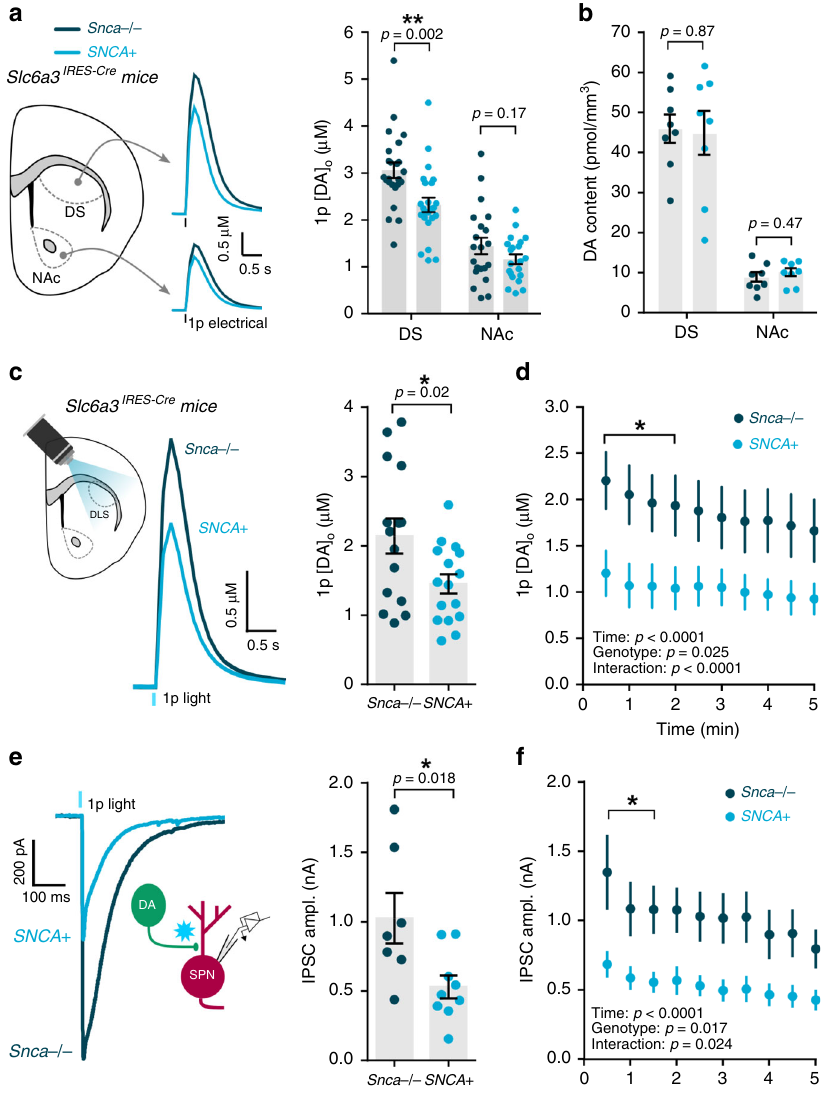
Fig. 7 Attenuated striatal GABA and DA co-release from DA axons in mouse model of early parkinsonism. a Left, mean [DA] o pro fi les vs. time evoked by a single pulse ( 1p ) of electrical stimulation in dorsal striatum (DS) and nucleus accumbens (NAc) of SNCA + mice (light blue) and littermate controls ( Snca − / − , dark blue) at 3 – 4 months, backcrossed onto an Slc6a3 IRES-Cre background. Right, Mean 1p-evoked [DA] o (in μ M) from Left ( n = 24 observations/5 mice per genotype in DS, n = 21 observations/5 mice per genotype in NAc). b Mean DA content in DS and NAc of SNCA + mice (light blue) and littermate controls ( Snca − / − , dark blue) ( n = 8 experiments/5 mice per genotype in DS and NAc). c Left, mean [DA] o pro fi les vs. time following 1p light simulation in DLS of SNCA + mice (light blue) and littermate controls ( Snca − / − , dark blue). Right, Mean 1p-evoked [DA] o (in μ M) from Left ( n = 15 observations/3 mice in Snca − / − mice, n = 16 observations/3 mice in SNCA + mice). d Mean 1p light-evoked [DA] o (in μ M) recorded every 30 s in DLS of SNCA + mice (light blue, n = 7 experiments/3 mice) and littermate controls ( Snca − / − , dark blue, n = 7 experiments/3 mice). e , f Mean 1p light-evoked inhibitory postsynaptic currents (IPSCs) recorded from spiny projection neurons (SPNs) every 30 s in the DLS of SNCA + mice (light blue, n = 9 cells/4 mice) and littermate controls ( Snca − / − , dark blue, n = 7 cells/4 mice), voltage clamped at − 70 mV and in the presence of ionotropic glutamate receptor antagonists (NBQX, 5 μ M; D-APV, 50 μ M). Two-tailed Student ’ s unpaired t -tests ( a – c , e ) and two-way repeated-measures ANOVA with Sidak ’ s multiple comparison tests ( d , f ). * p < 0.05, ** p < 0.01. Error bars are ±SEM. Source data are provided as a Source Data fi